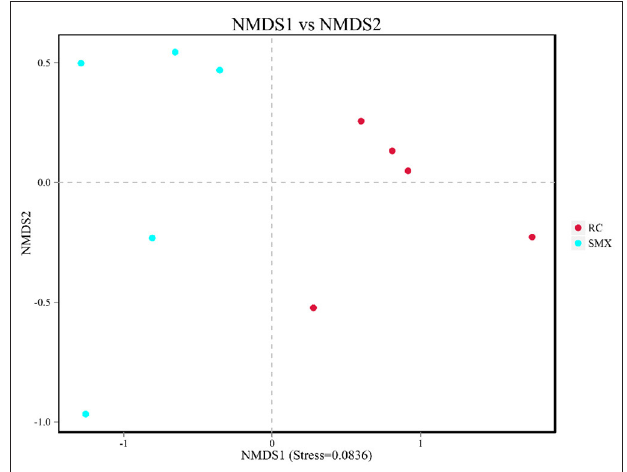
FIGURE 5 | Non-metric multidimensional scaling (NMDS) analysis. Each point in the graph represents one sample, and different colors represent different groups. The distance between points represents the level of difference. Stress lower than 0.2 indicates that the NMDS analysis is reliable. The closer the samples in the graph, the higher their similarity.